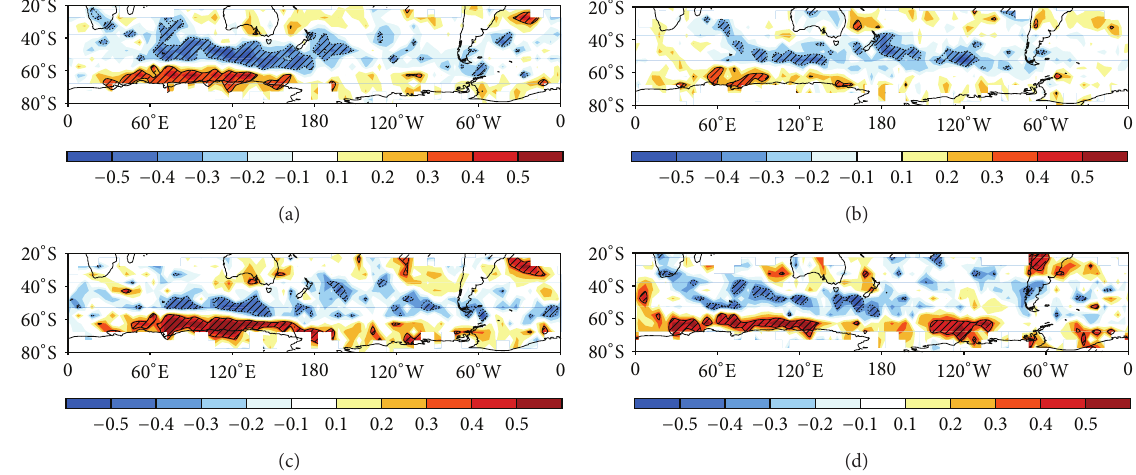
Figure 8: Partial correlation coefficient for cyclone frequency versus AAO (excluding IOD and ENSO) for SH Winter (JAS). Correlation (shaded), 2-Tail 90% significance (hatched) for (a) NCEP1 5801, (b) ERA40 5801, (c) NCEP1 7910, and (d) NCEP1